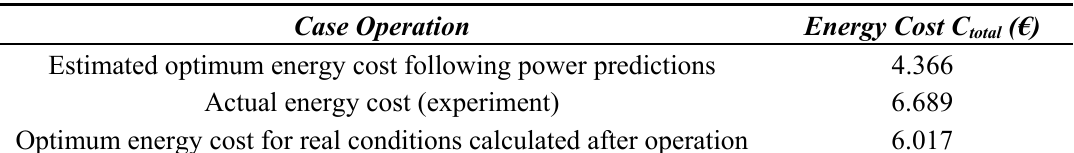
Table 4. Energy Cost Comparison for Test 2.